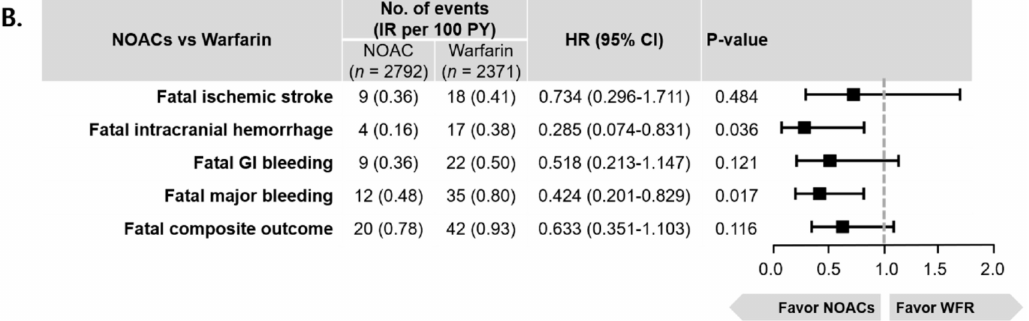
Figure 3. Weighted event numbers, incidence rates, and HRs of 6 clinical outcomes and fatal events in NOAC versus warfarin (reference) in patients with EHRA type 2 VHDs: ( A ) HRs of 6 clinical outcomes; ( B ) HRs of fatal clinical events. Compared to warfarin, NOACs were associated with lower risks of ischemic stroke, GI bleeding, and major bleeding. Although NOAC and warfarin groups showed similar incidence rates of ICH, the NOAC group was associated with a significantly lower risk of fatal ICH compared to warfarin group. Overall, NOACs were associated with a lower risk of the composite outcome (HR: 0.68, 95% CI: 0.58–0.80). Abbreviations: CI, confidence interval; GI, gastrointestinal; HR, hazard ratio; ICH, intracranial hemorrhage; NOAC, non-vitamin K antagonist oral